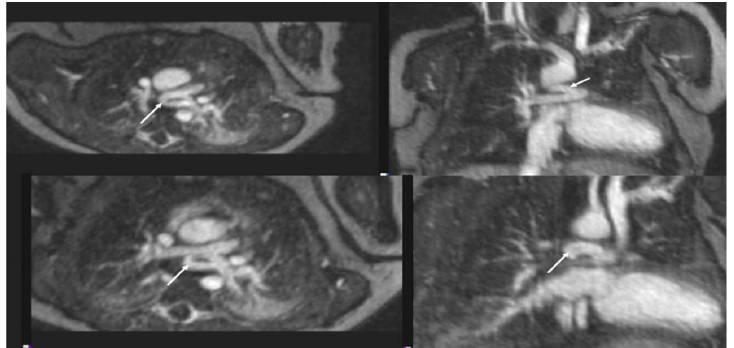
Figure 7. Tetralogy of Fallot with Pulmonary Atresia. Reformatted multiplanar maximum intensity projections from a 4D FE-MRA (MUSIC) study in a neonate. Continuous right and left branch pulmonary arteries are seen supplied by a patent ductus arteriosus (solid arrow) from the underside of the aortic arch. This study was used to plan transcatheter ductus arteriosus stent placement. No significant aortopulmonary collateral arteries were identified.